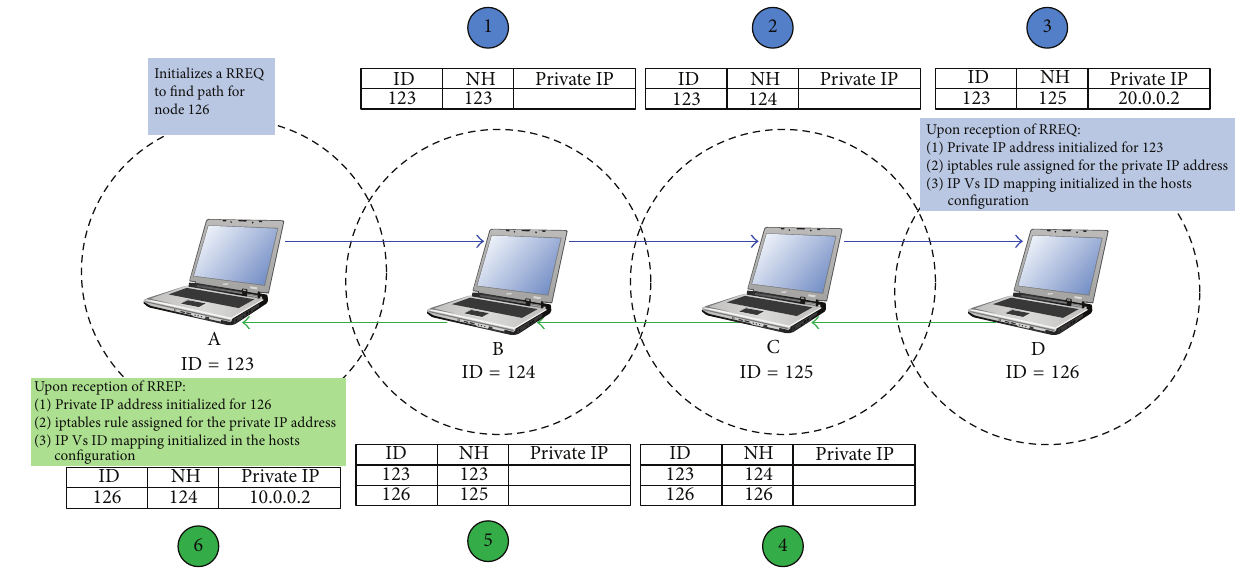
Figure 15: Path establishment process between